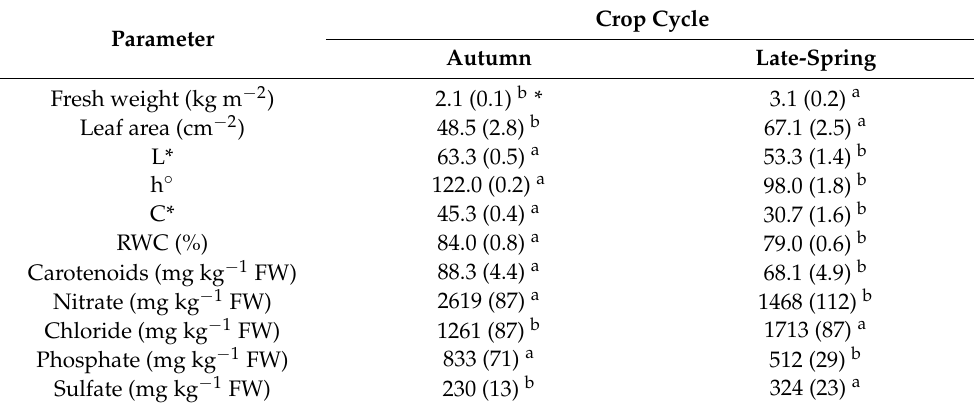
Table 6. Effect of crop cycle on yield, bio-morpho-physiological traits, and the main inorganic anion and antioxidant compound concentrations in oak-leaf lettuce. Crop Cycle Parameter Autumn